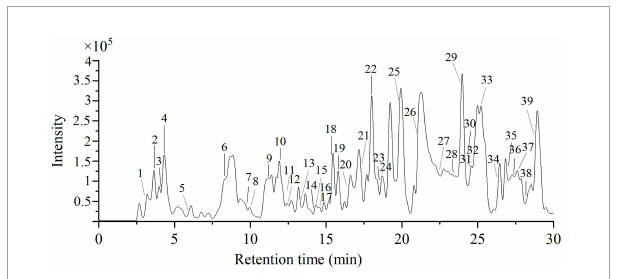
FIGURE6 The total ion chromatography of 70% ethanol extract of PRA under negative